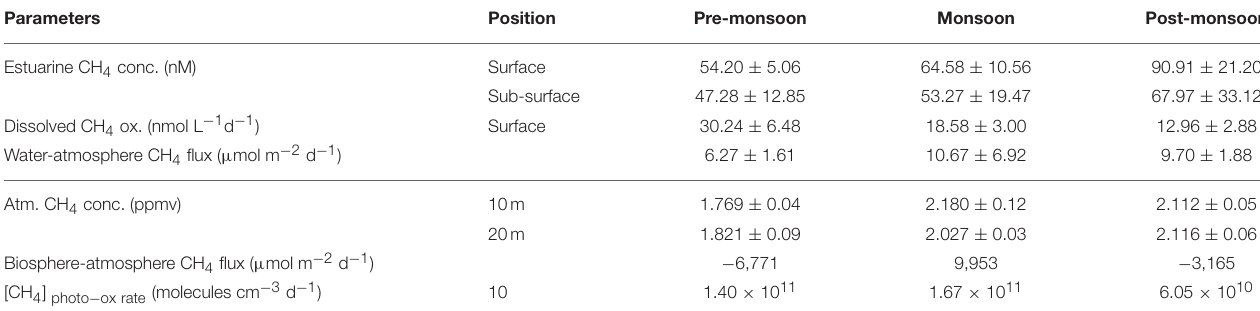
TABLE 1 | Seasonal variation (mean ± SD) of estuarine and atmospheric CH 4 concentrations, oxidation and exchanges across different interfaces. Parameters